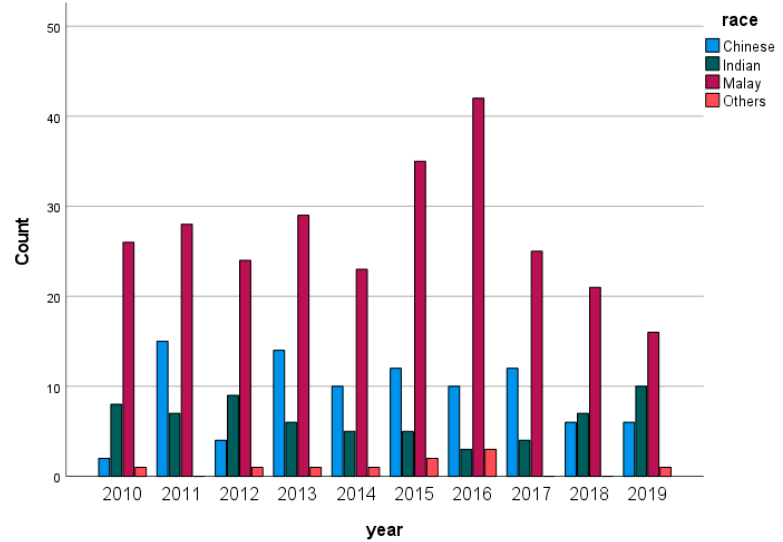
Figure 1. Distribution of populations with diabetic foot infections from 2010 to 2019.